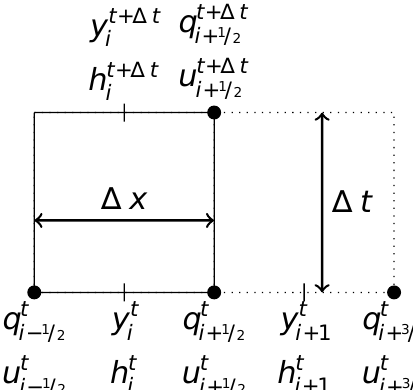
Figure 1. Grid and variables used in the numerical scheme. Time is shown in the vertical axis. Variables at the bottom are used at time t to calculate variables at the top at time t + (cid:49)t